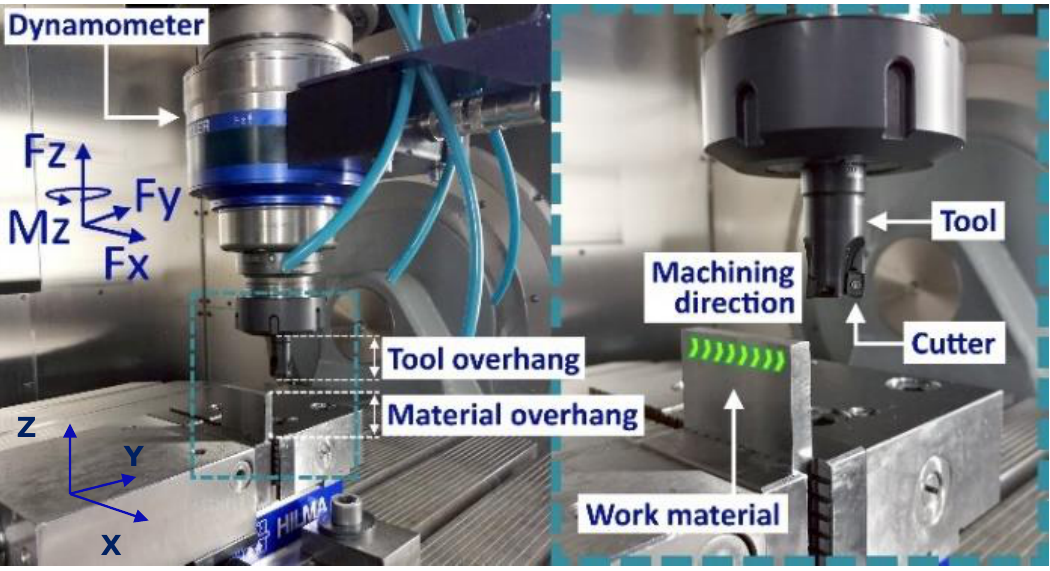
Figure 3. Machining setup and force directions. Table 2. Milling operation parameters.